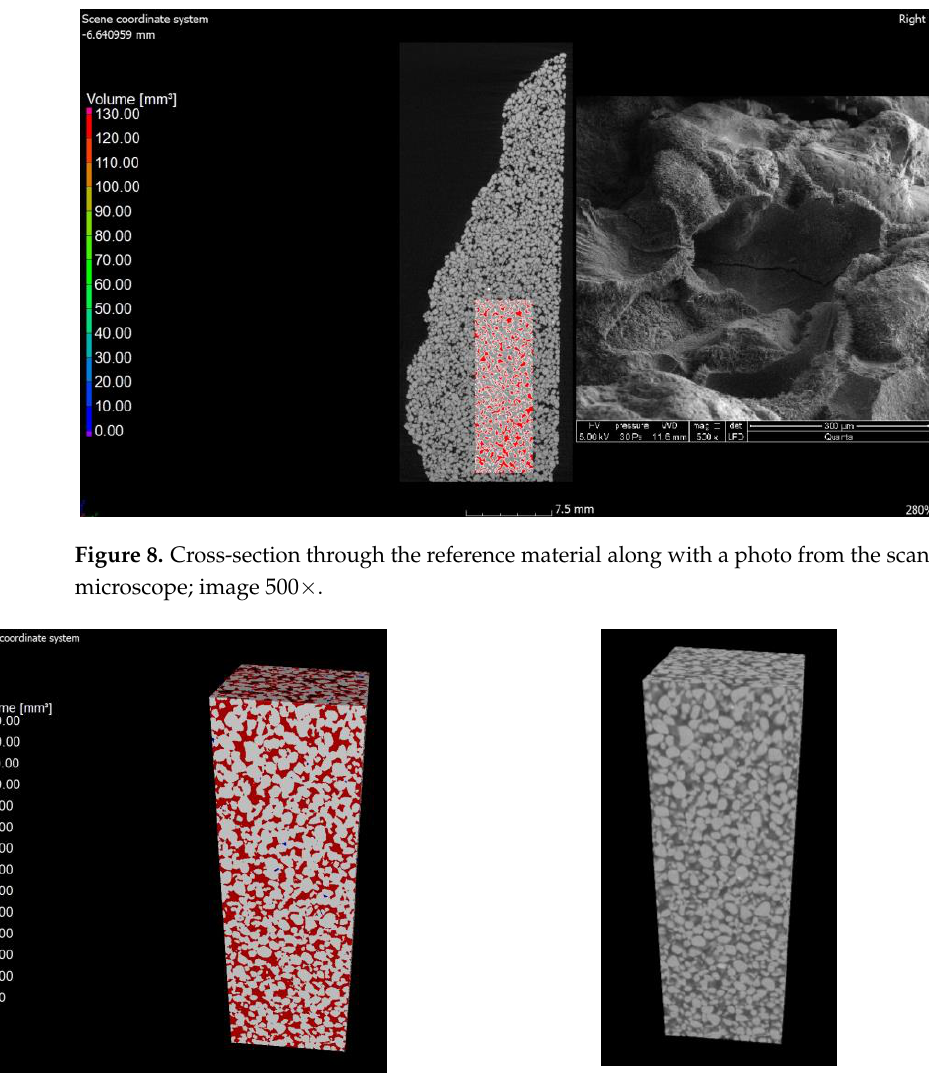
Figure 7. Cross-section of a sample in traditional brick. Red spots are visible free spaces that were formed at the interface between SiO 2 and CaO grains and after the hydration and autoclaving process.